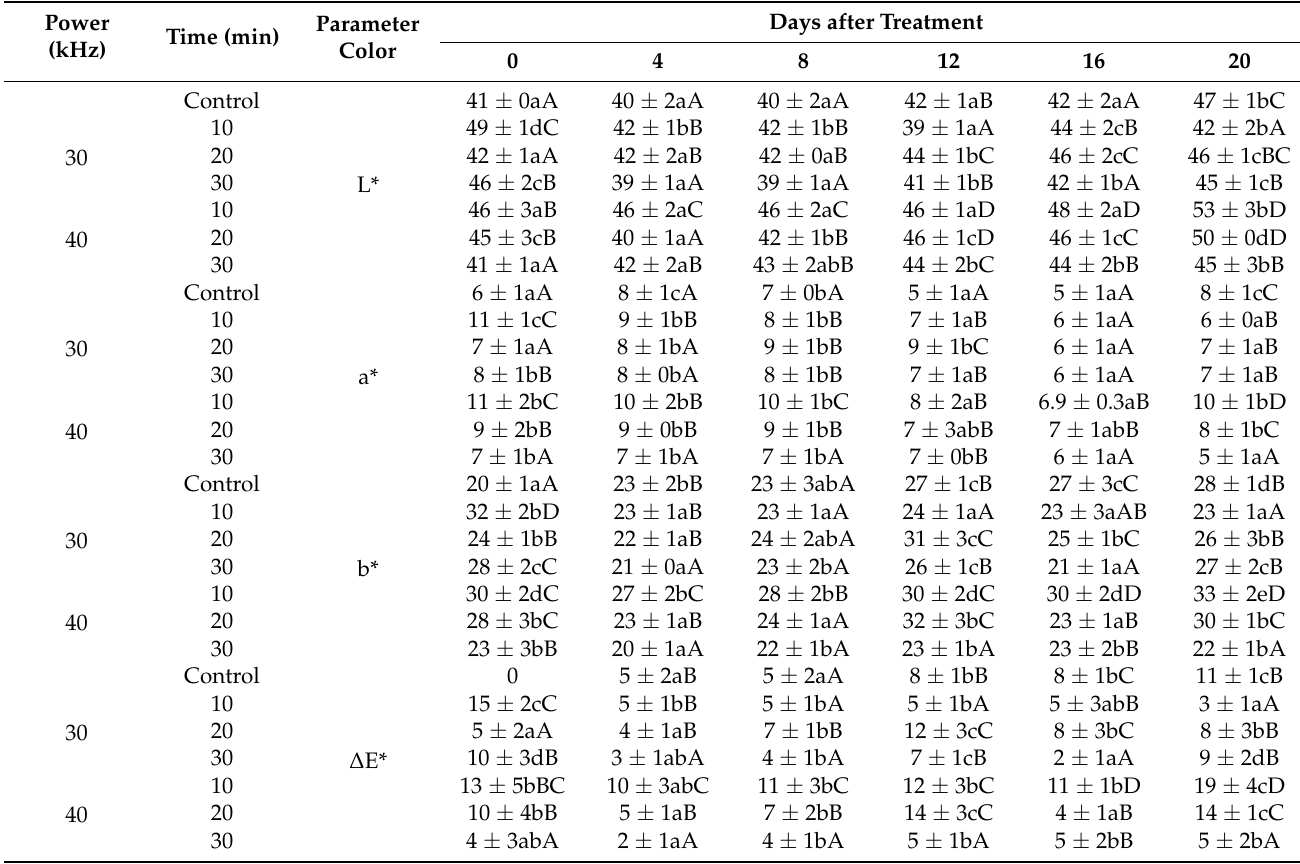
Table 5. Color analysis of Passiflora edulis f. edulis Sims (gulupa) pulp subjected to low-frequency ultrasound treatments stored at 4 ◦